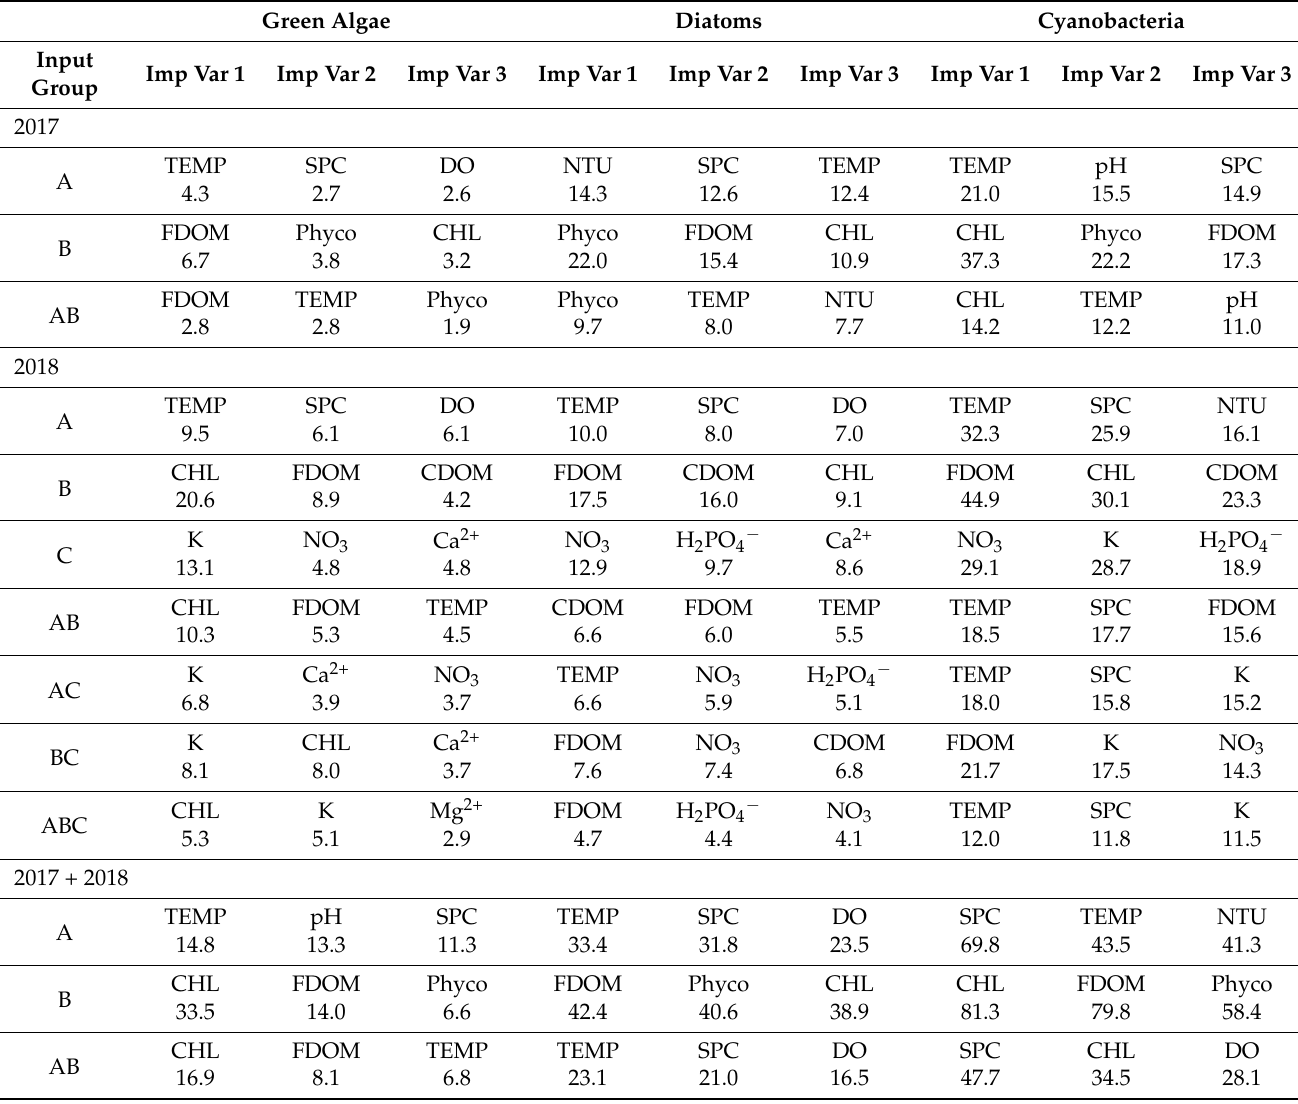
Table 3. Most influential predictors and the increase in accuracy (%)for that variable for Pond 1 as determined using the random forest algorithm.